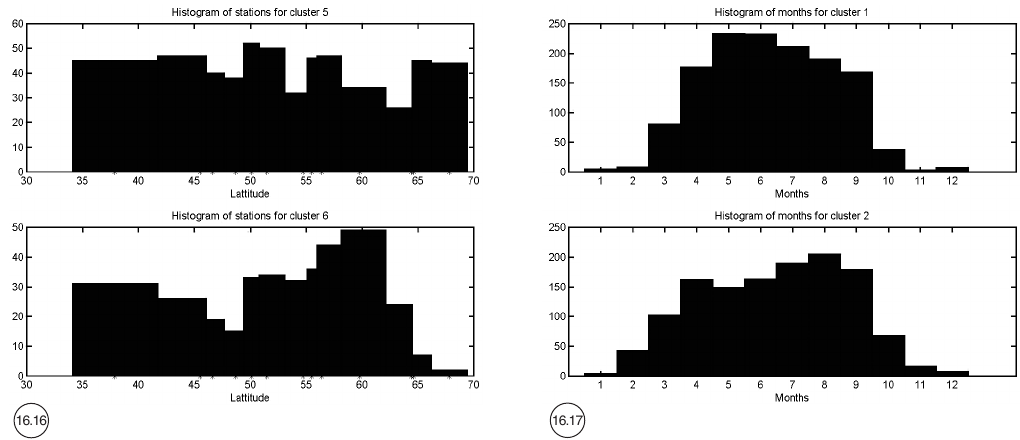
16.16 Fig. 16.16. Histogram of the stations from low latitude to mid and high latitude (37.9N to 67.8N), for Cluster 5 and Cluster 6. Fig. 16.17. Histogram of months (from January to December), for Cluster 1 and Cluster 2.